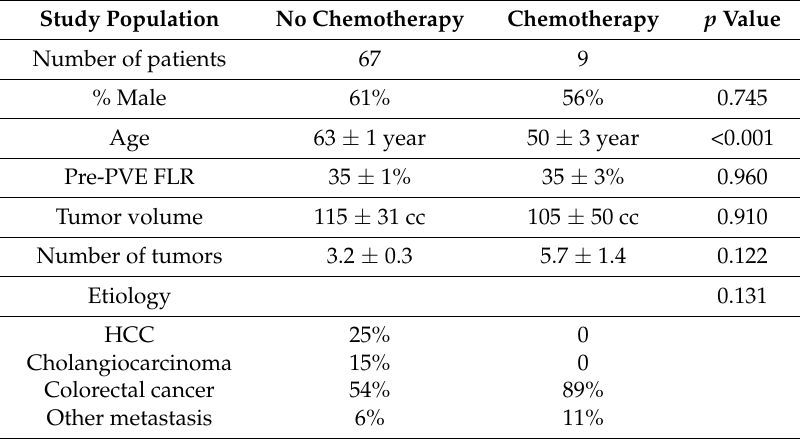
Table 1. Demographics and pre-procedural characteristics of patients who did and not receive chemotherapy between portal vein embolization (PVE) and hepatic